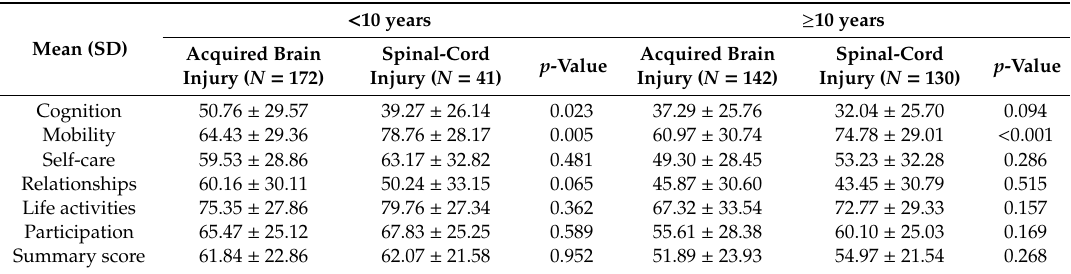
Table 4. Comparison of WHODAS 2.0 scores of overall disability across domains between participants with brain and spinal-cord injuries according to onset